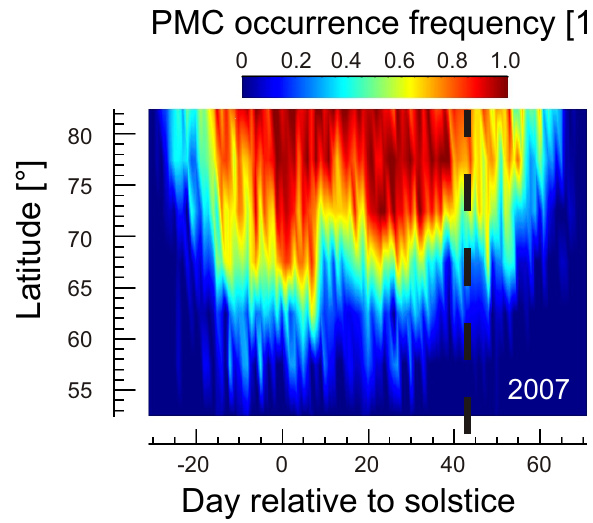
Fig. 1. Daily mean NLC occurrence frequency from middle to high latitudes during summer 2007 as observed by SCIAMACHY on En- visat. 3/4 August 2007 is marked by a black